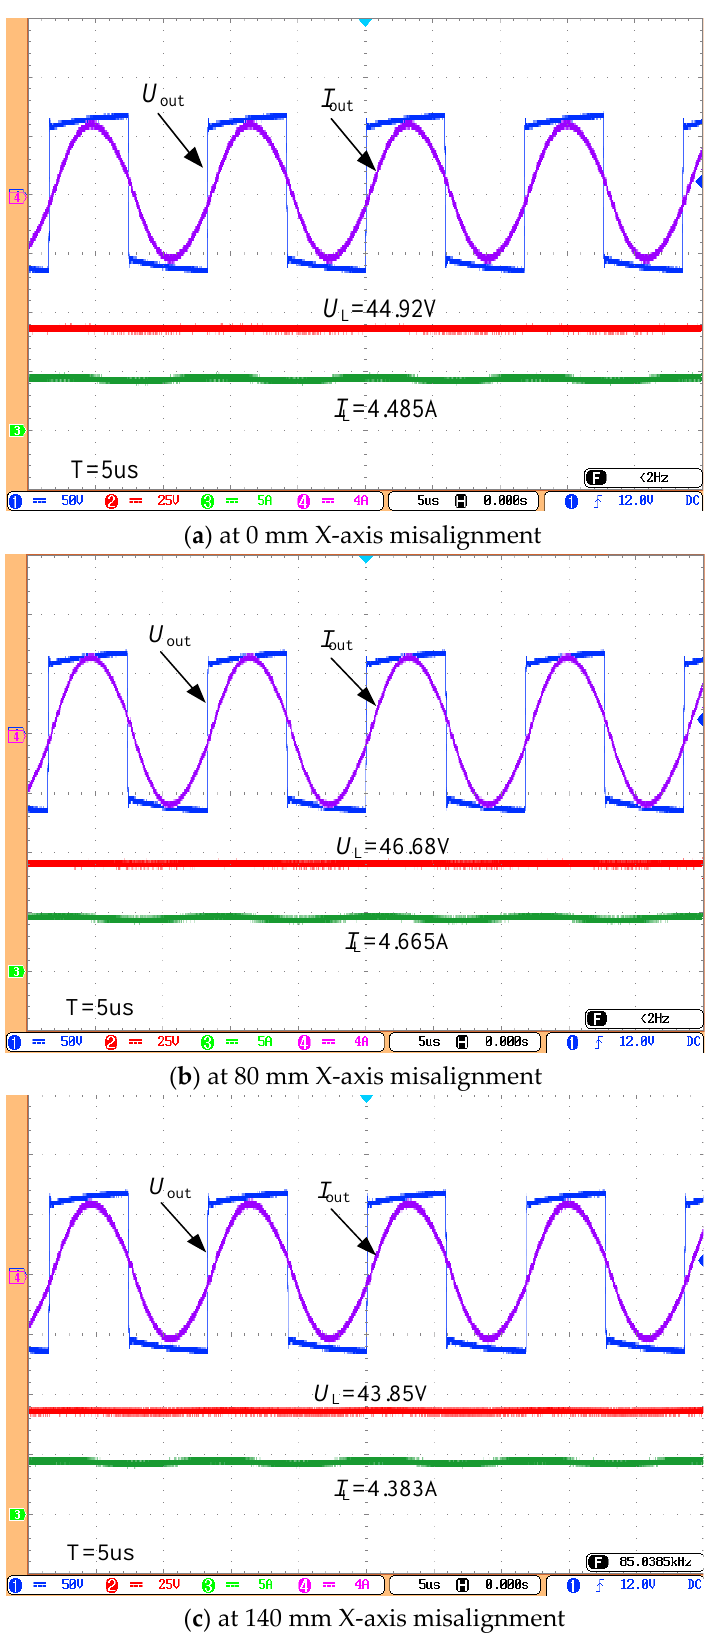
Figure 12. Experimental waveforms at R L = 10 Ω.